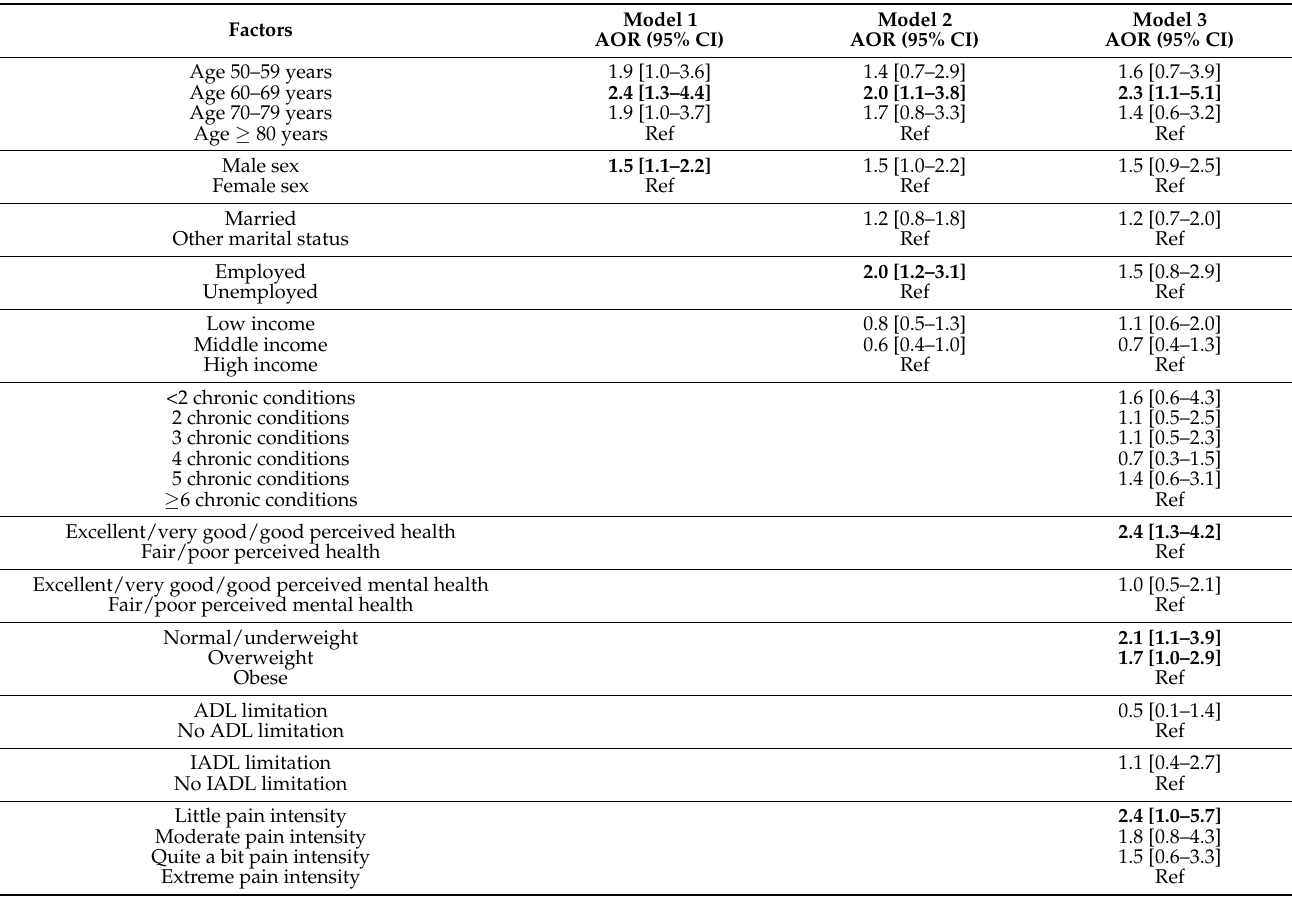
Table 2. Characteristics associated with frequent exercise (versus no frequent exercise) among United States adults aged ≥ 50 years with self-reported pain in the past four weeks who used opioids in the 2020 Medical Expenditure Panel